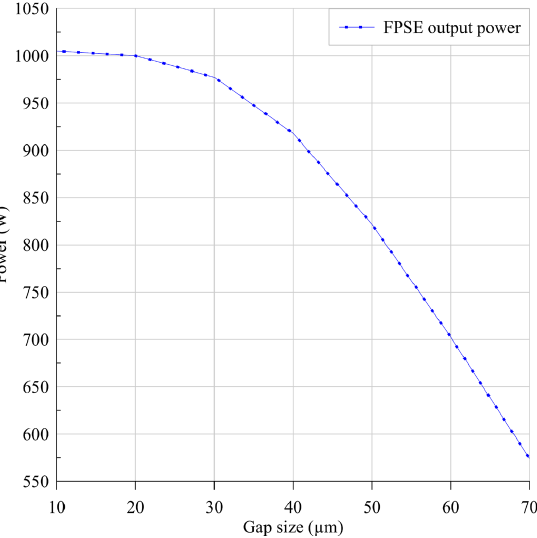
Figure 19. Effect of the gap size on the FPSE power production.